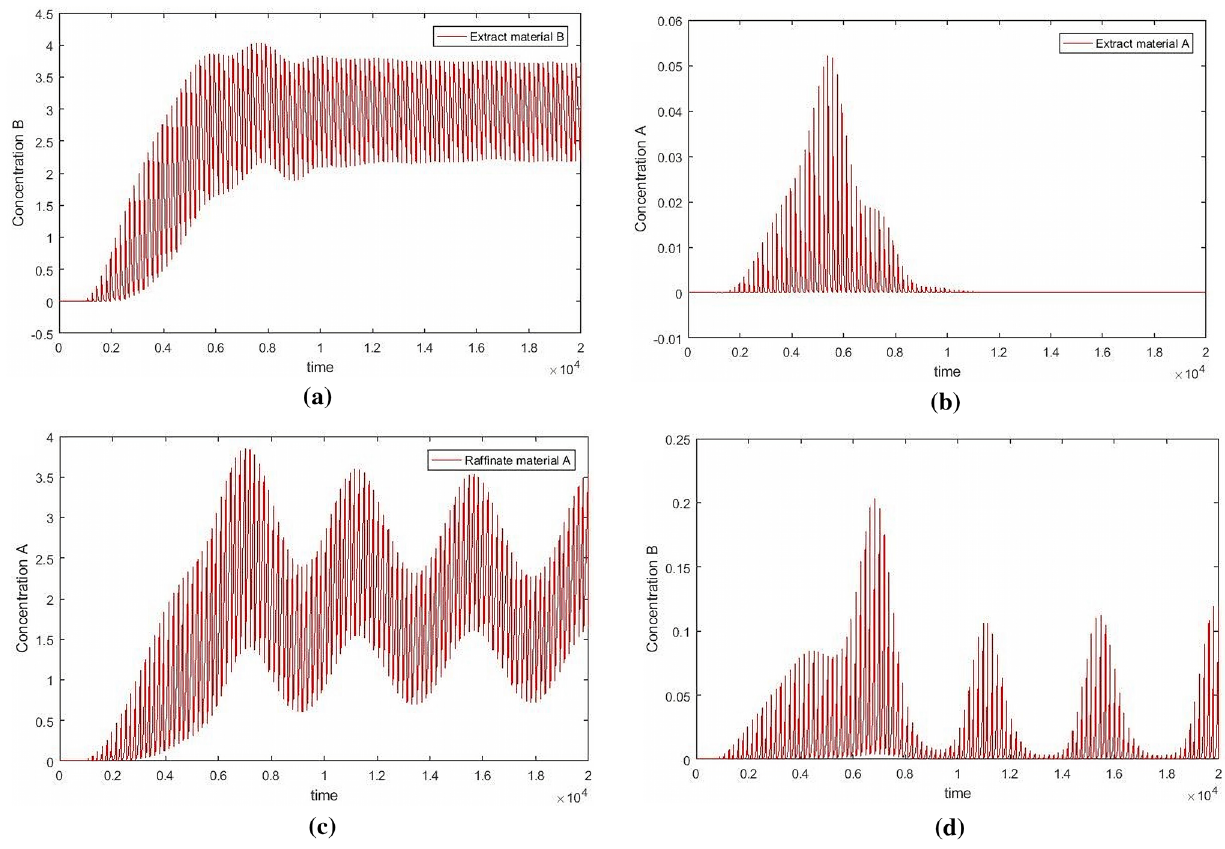
Figure 10. Hierarchical Fuzzy Rule Control for concentration, desired B = 3, desired A = 2, Switch time = 180